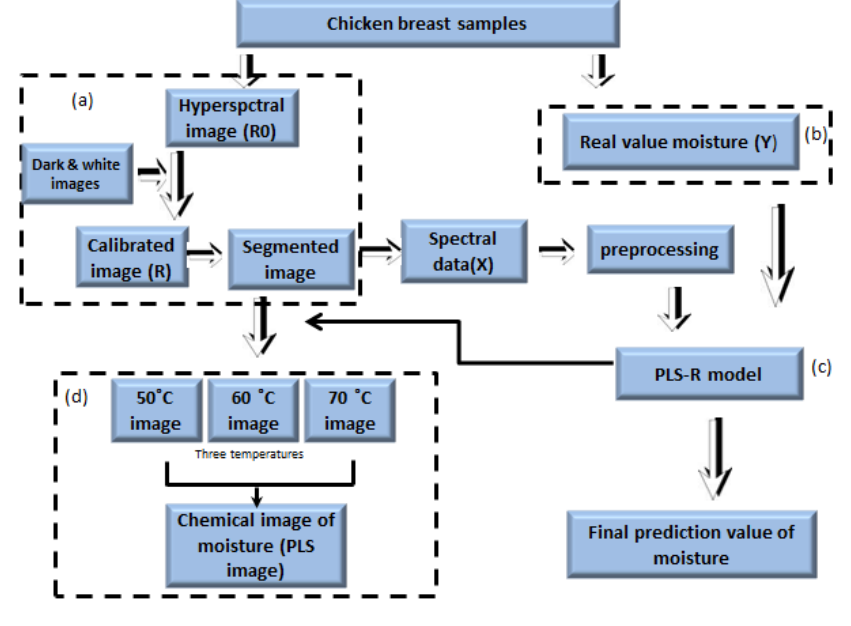
Figure 2. Experiments and image processing flow: ( a ) acquiring and correcting spectral images; ( b ) measurement of moisture contents; ( c ) prediction of moisture content using a PLSR model and ( d ) PLSR images of the moisture content for different